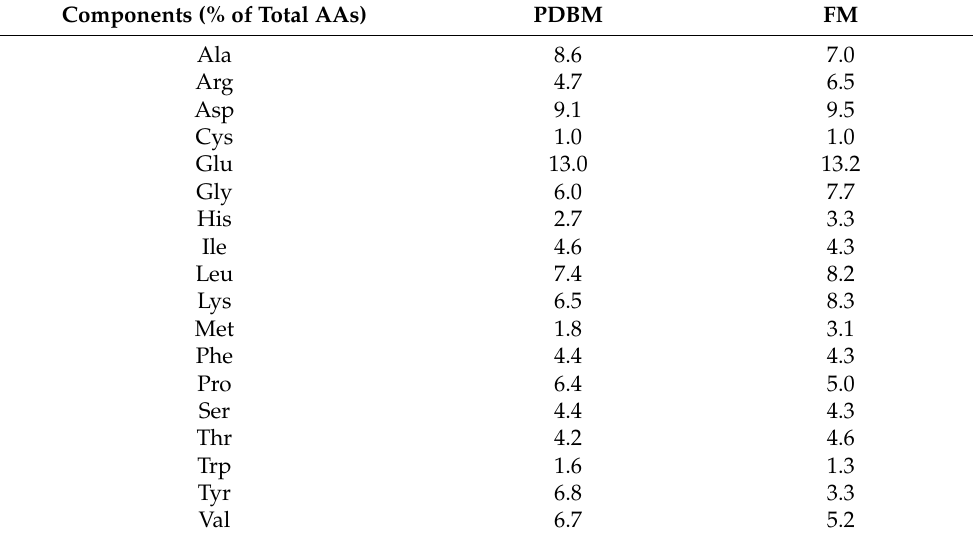
Table 4. Amino acid (AA) profile of black soldier fly larvae meal in this study. Components (% of Total AAs)